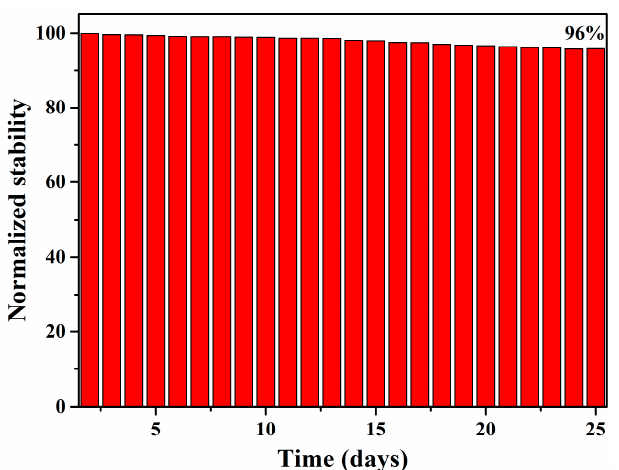
Figure 10. Relationship between the times and response of the 0.5 wt.% Au/TiO 2 NTs in 50 µ M glucose solution.